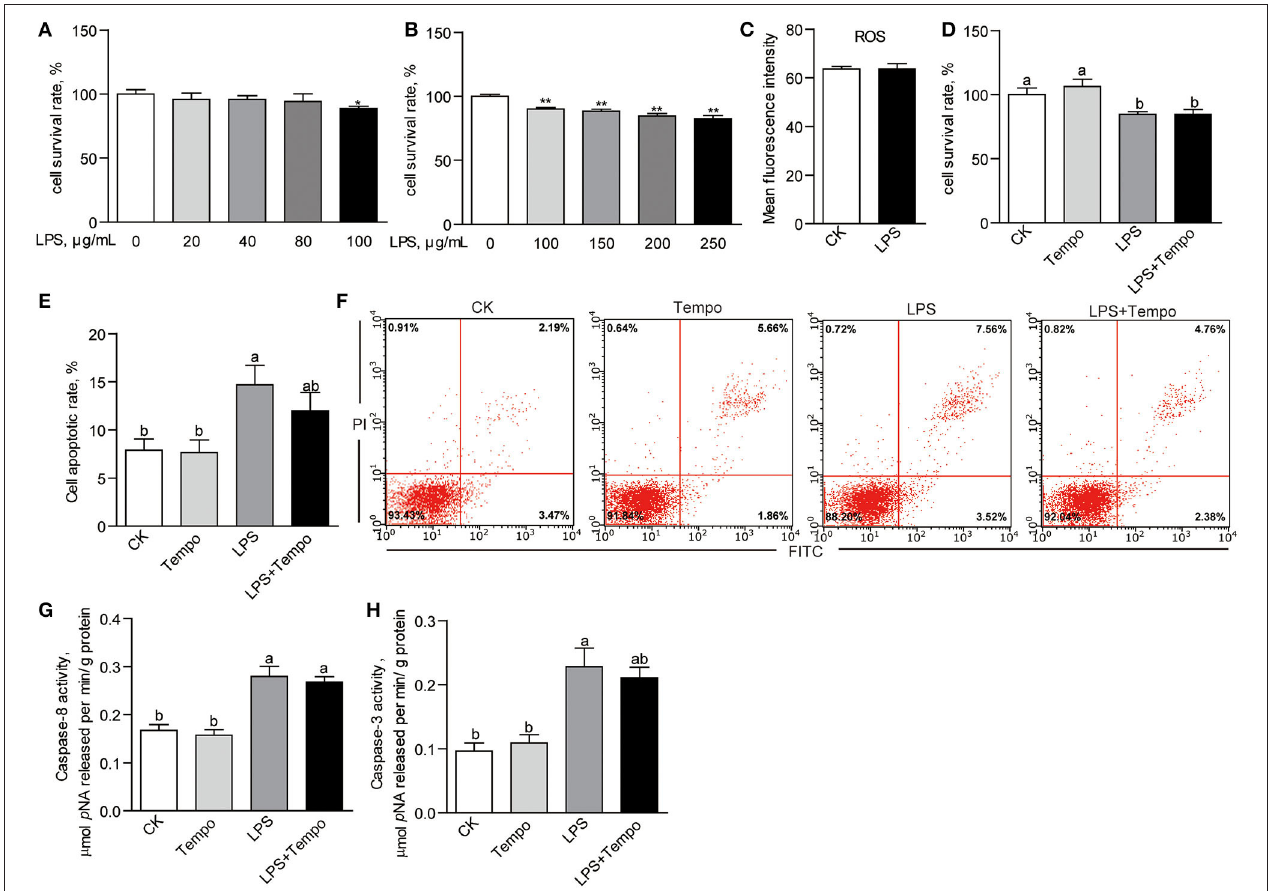
FIGURE 7 | The effects of LPS on cell viability and apoptosis of ZFL cells. (A) The cell survival rates of ZFL cells treated with lower concentrations of LPS for 24h. (B) The cell survival rates of ZFL cell treated with higher concentrations of LPS for 24h. (C) The intracellular ROS of ZFL cells treated with 100 µ g/ml LPS for 24h. (D) The cell survival rates and (E) cell apoptotic rates of ZFL cells co-treated with LPS and tempo for 24h. (F) The representative images of cell apoptosis of ZFL cells co-treated with LPS and tempo for 24h. The activities of (G) caspase-8 and (H) caspase-3 in ZFL cells co-treated with DHA and tempo for 24h. The values are means ± SEMs ( n = 3–8 biological replicates). The mean values without a common letter are significantly different, p < 0.05. * p < 0.05, ** p <